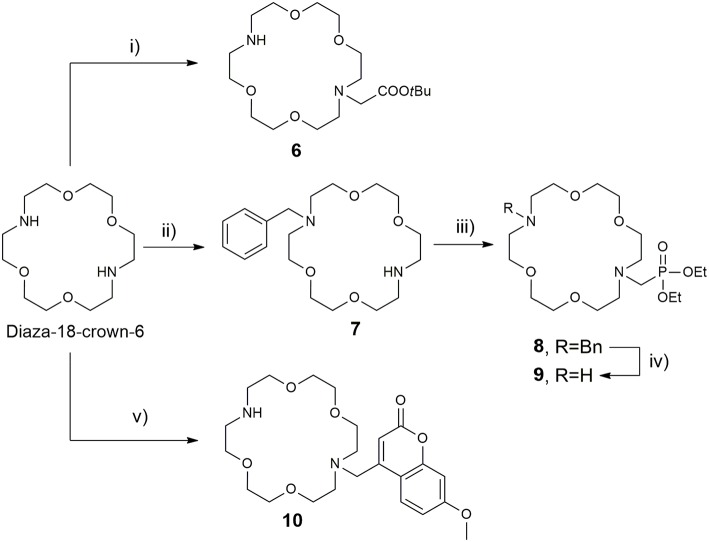
Synthesis of 18-azacrown-6-ether fragments 6, 9, and 10. Reagents and conditions: (i) tert-butyl bromoacetate (0.95 equiv), CHCl3, Et3N, RT, 48 h, 62%; (ii) BnCl (0.95 equiv), CHCl3, Et3N, RT, 60 h, 58%; (iii) (C2H5O)2P(H)O, CH2O, CH2Cl2, BF3·Et2O, anh. Na2SO4, 65°C, 60%; (iv) H2, Pd(OH)2/C, EtOH, 3 bar, 94%; (v) Br-Mmc, MeCN, NaHCO3, RT, 40%.